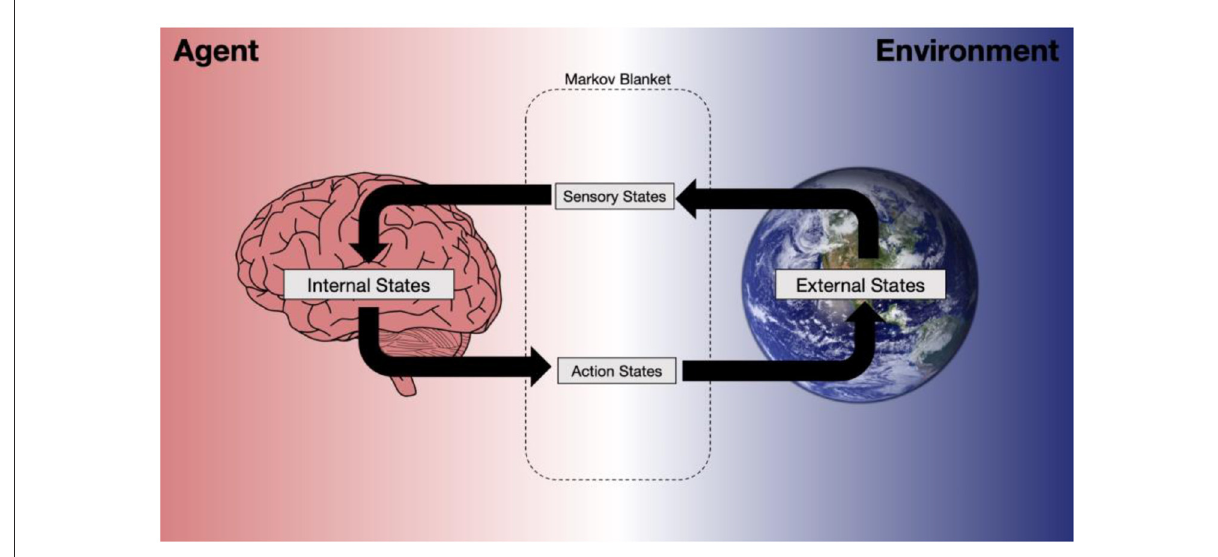
FIGURE1 An illustration of how a model of the external world is formed, resulting in beliefs about the true states of the world and belief updating, encoded by internal